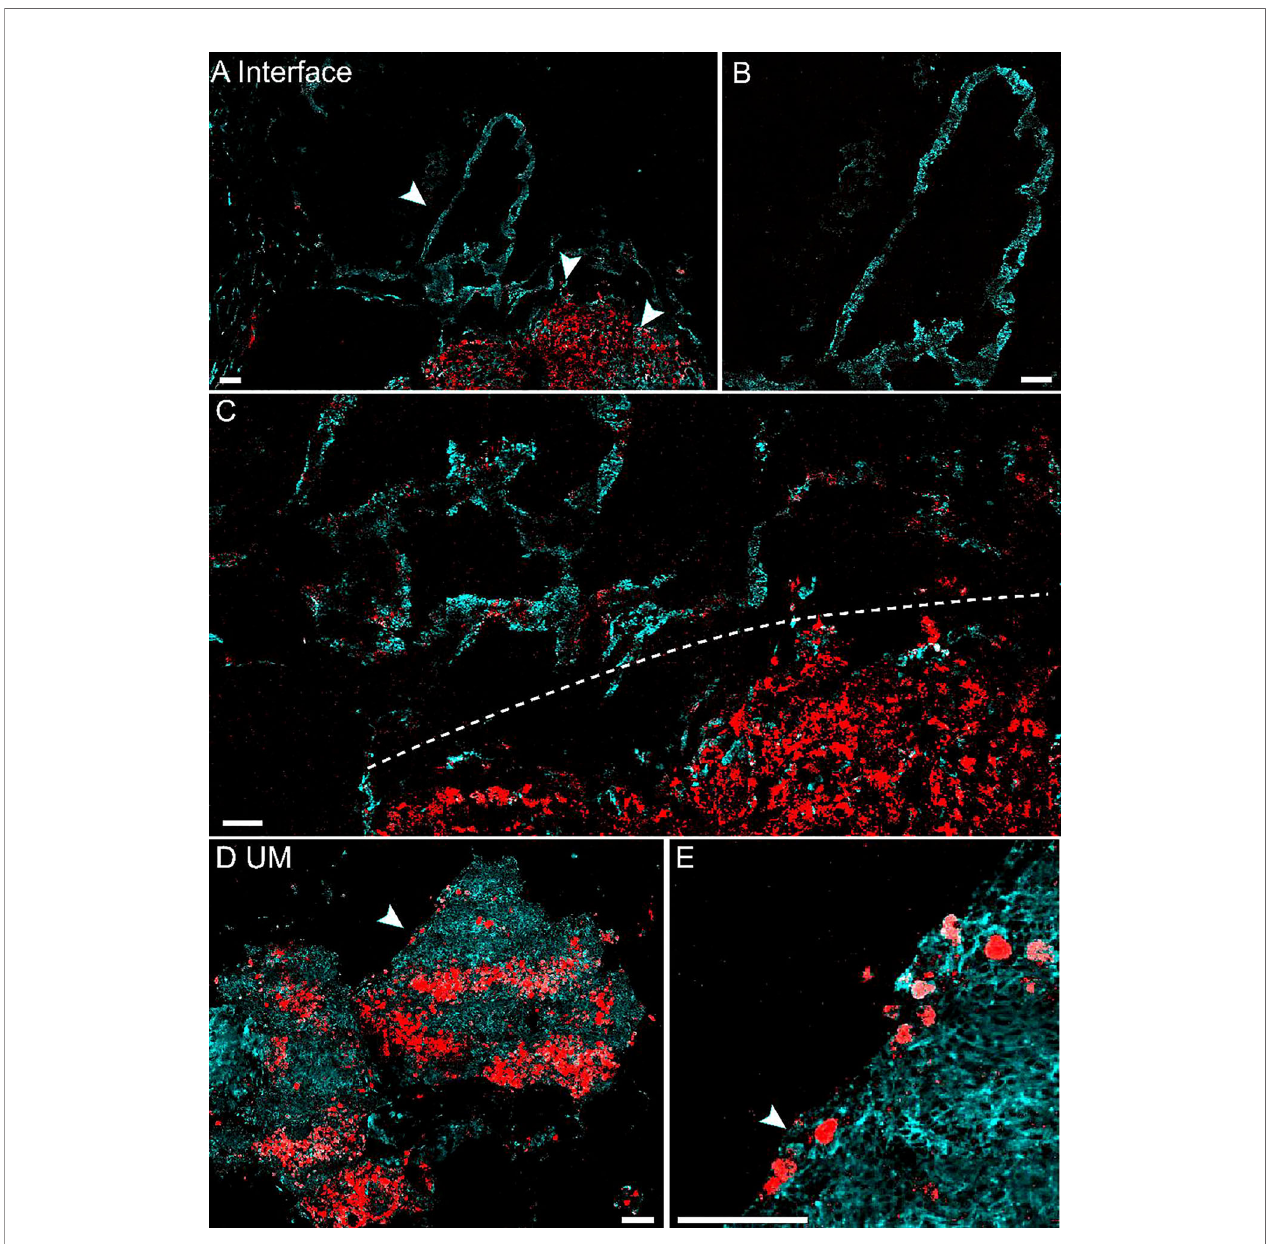
(E) Magni fi ed view of the eumelanin deposition, while the melanocytes are rich in pheomelanin. Red: eumelanin; cyan: pheomelanin. Scale bar: 50 m